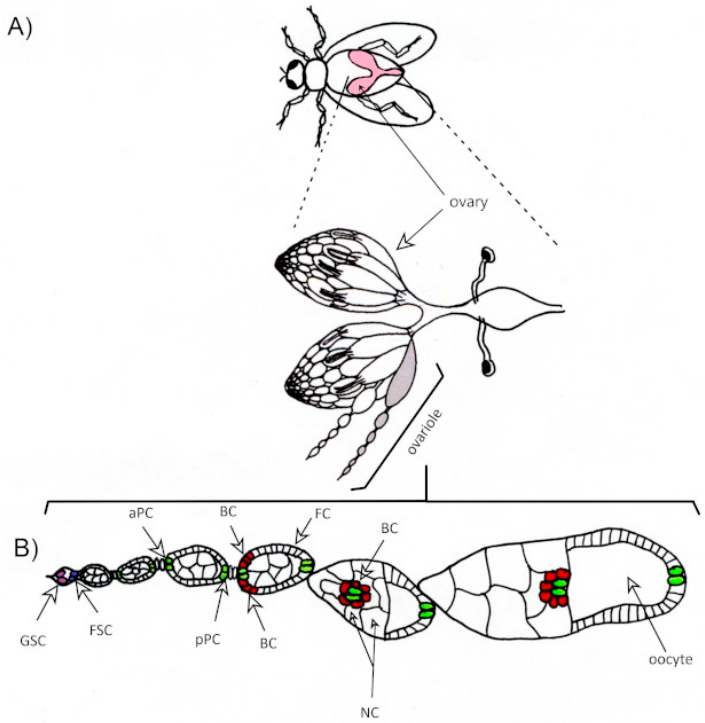
Figure 1. ( A ) Schematic diagram of reproductive system of Drosophila melanogaster. ( B ) Migration of border cells in the developing ovarian follicle. GSC—germline stem cell, FSC—follicle stem cell, aPC—anterior polar cell, pPC—posterior polar cell, BC—border cell, FC—follicle cell, NC—nurse cell.